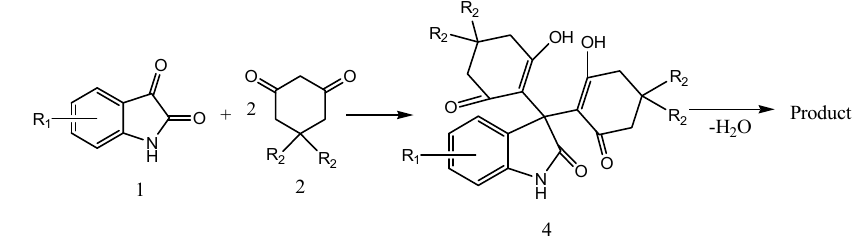
Figure 1 . Proposed mechanism for the synthesis of spiro[indoline-3,9 ′ -xanthene]trione. Figure 1. Proposed mechanism for the synthesis of spiro[indoline-3,9 (cid:48)